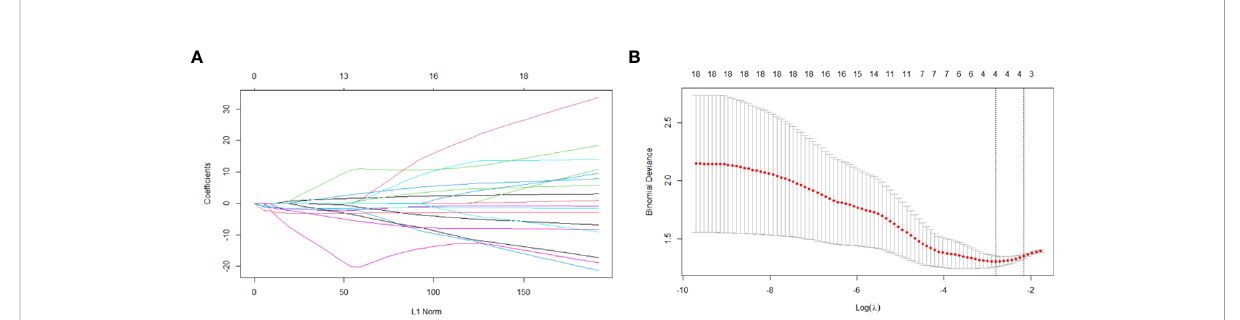
FIGURE 4 Variable selection based on the LASSO regression model. A coef fi cient pro fi le plot was produced against the log(lambda) sequence (A) . Four variables with non-zero coef fi cients were selected by optimal lambda. By verifying the optimal parameter (lambda) in the LASSO model, the partial likelihood deviance (binomial deviance) curve was plotted versus log(lambda) and dotted vertical lines were drawn based on 1 standard error criterion (B) .